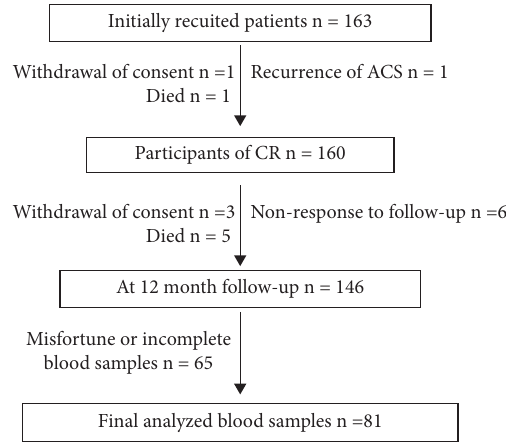
Figure 1: Flowchart of participant recruitment in the